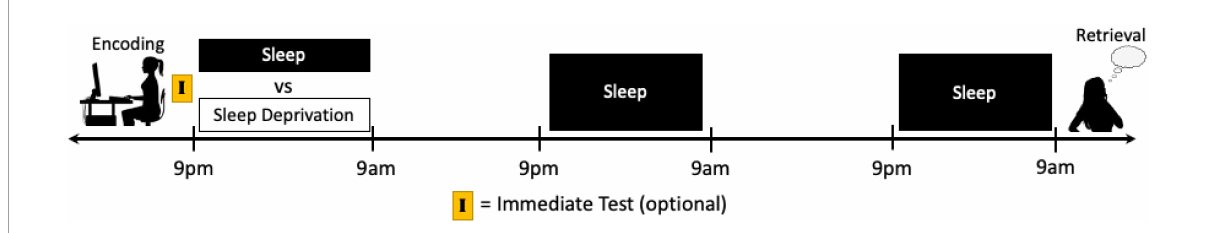
FIGURE4 Schematics of a potential study protocol designed to target the effects of sleep manipulation on the early consolidation stage of emotional memory processing. Participants can complete an encoding task immediately prior to a period of sleep or sleep deprivation. By allowing multiple nights of recovery sleep prior to retrieval, the effects of the sleep manipulation can be limited primarily to the early consolidation period. Moreover, an immediate test directly after encoding can be used to determine within-subject memory changes due to the different conditions. However, it must be kept in mind that the testing of memory itself may influence subsequent memory performance (see Footnote 4 and section